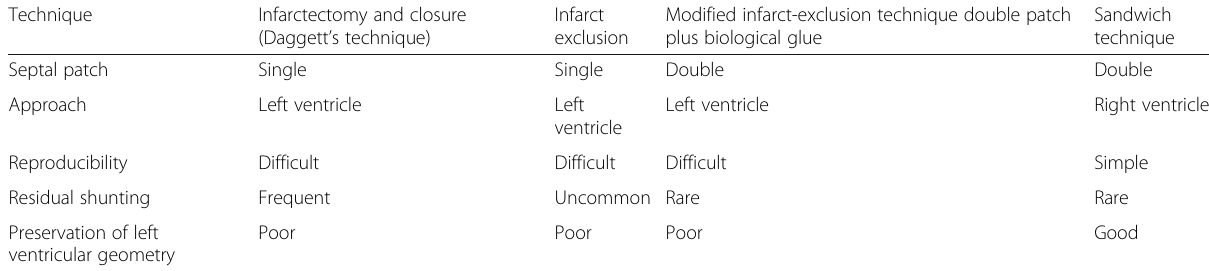
Table 3 Characteristics of common methods for surgical repair of post-infarction ventricular septal rupture